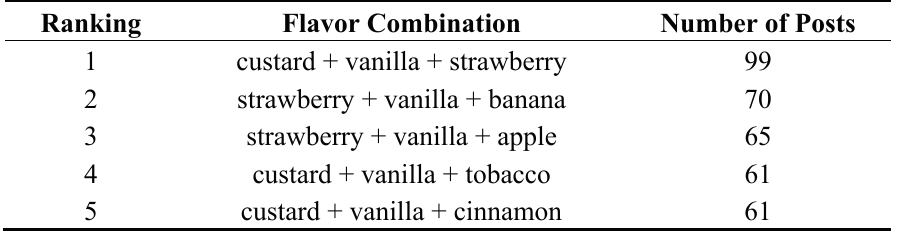
Table 4. Most popular three-flavor